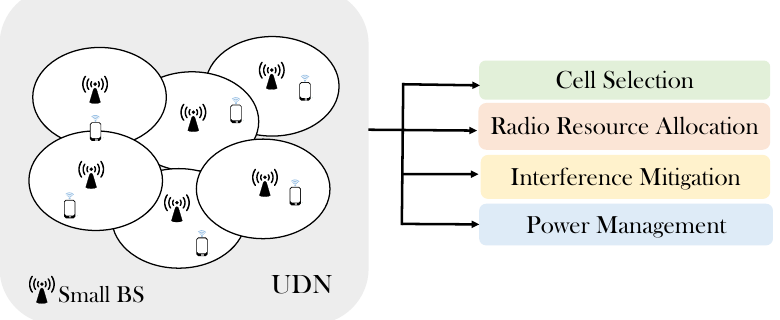
Figure 1. Main issues related to 5G ultra-dense